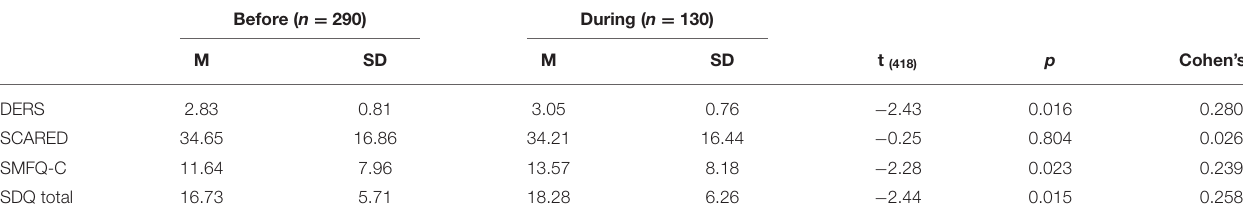
TABLE 2 | Mental health variables in children and adolescents before vs. during the COVID-19 pandemic.